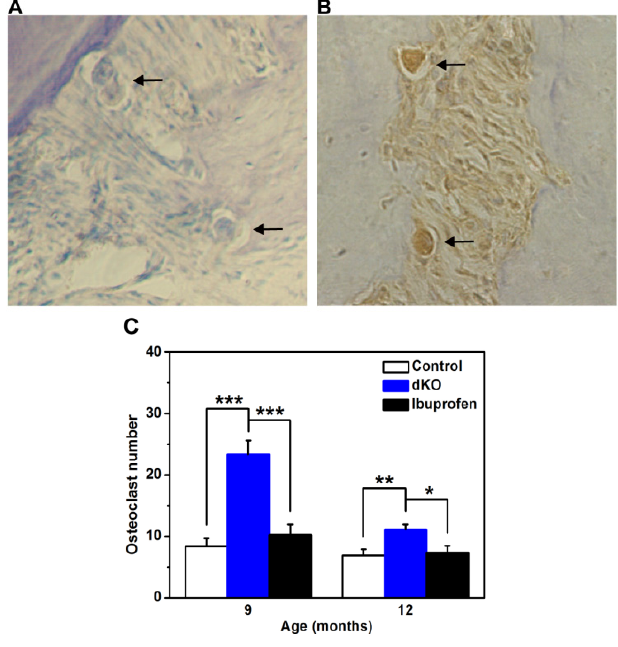
Figure 2. Representative examples of immunostaining of osteoclasts in periodontal ligaments of naive dKO mice. ( A ) Negative control for CTR immunostaining in periodontal ligament; ( B ) CTR-positive osteoclasts and resorption lacunae in periodontal tissue. Magnification for A and B is 400×; ( C ) The number of osteoclasts. CTR-positive cells in the periodontal ligament from five sections of each animal were counted. Values are mean ± SE. There were a significantly greater number of osteoclasts (CTR-positive cells) in naive dKO mice ( n = 9) compared with control mice ( n = 7–9)